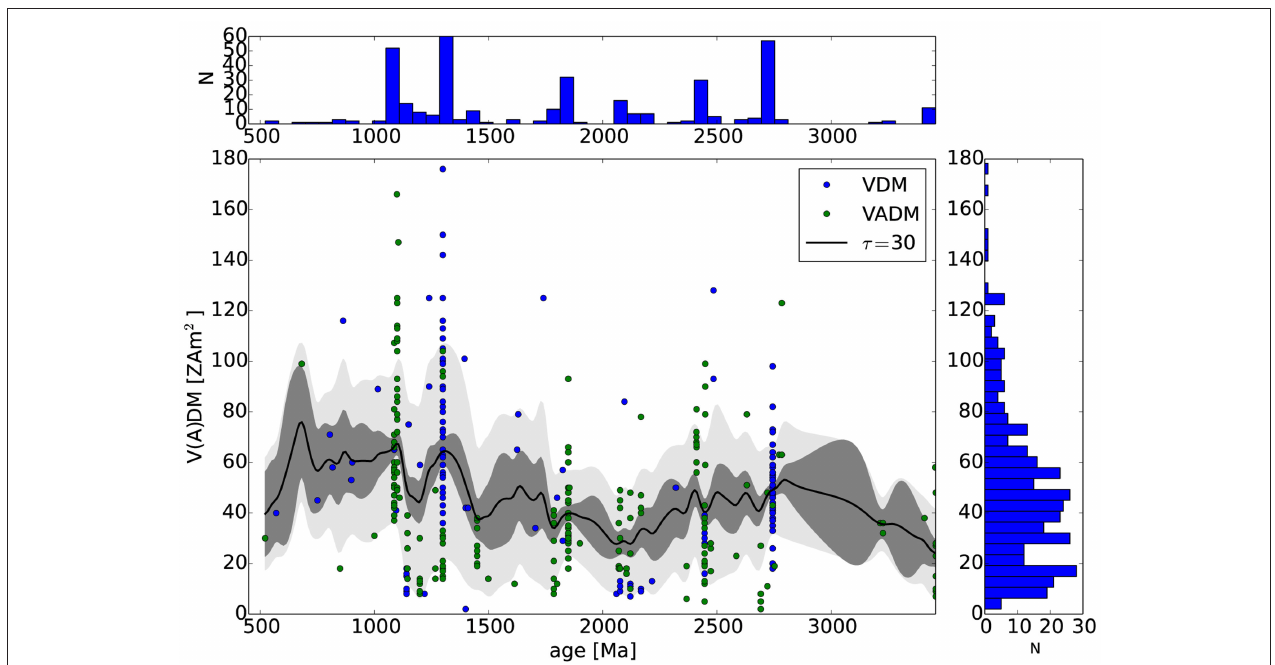
FIGURE 12 | Paleointensity (VDM and VADM) from the PINT database with inverse-distance squared smoothing length scale of τ IDS = 30 Myr (solid black line) including standard deviation (dark gray) and standard error (light gray). (Right) histogram of VDM and VADM. (Top) histogram of ages.